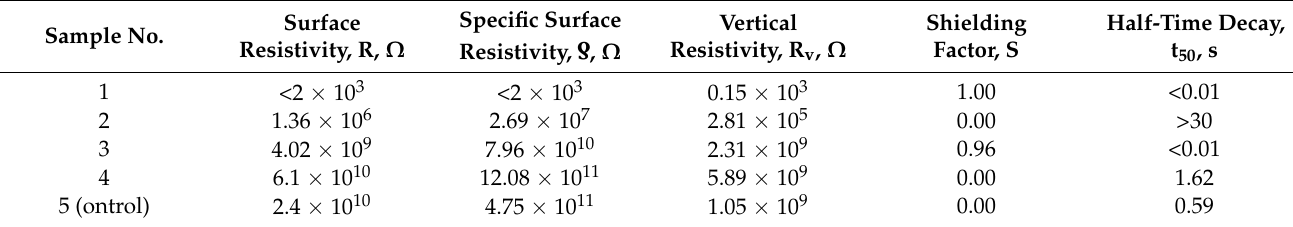
Table 3. Electrostatic properties of socks of different structures.